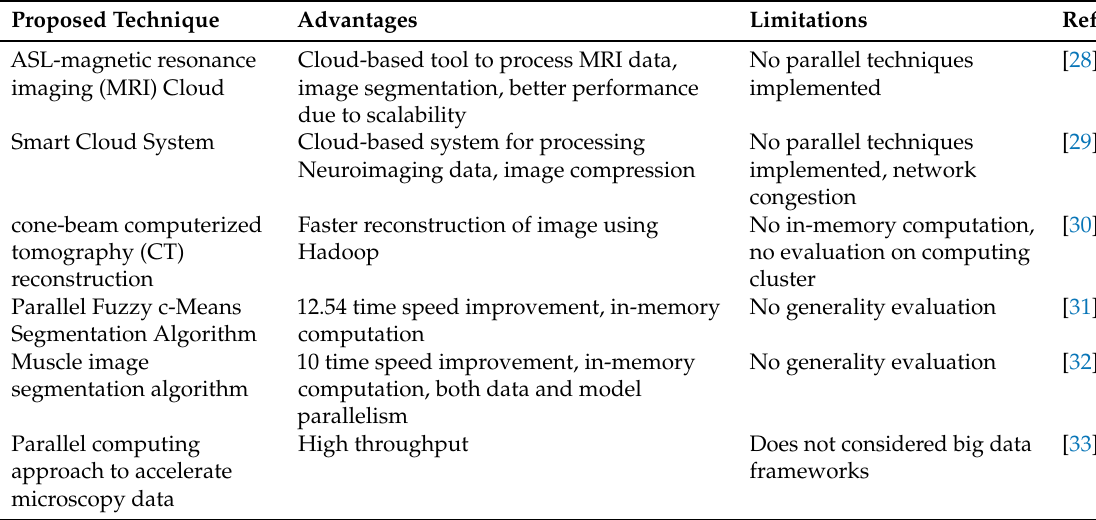
Table 1. Techniques for large scale image data processing using high-performance computing (HPC)/Cloud. Advantages Limitations